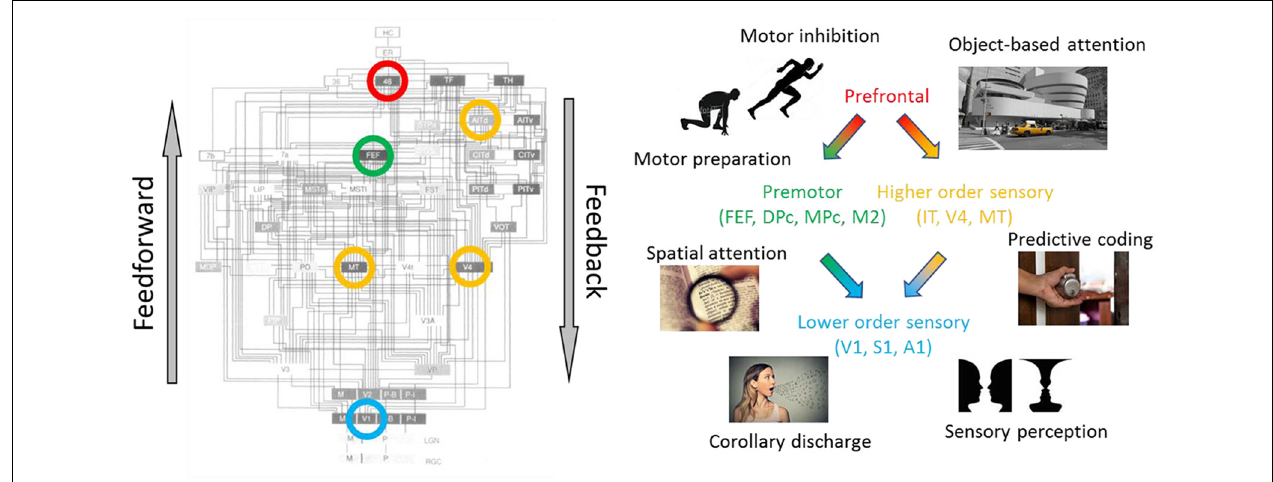
FIGURE 2 | Diverse functions of cortical feedback throughout the hierarchy. (Left) Hierarchical organization of the primate visual system adapted with permission from Felleman and Van Essen (1991). Circled regions are some of the cortical regions discussed in the manuscript. (Right) Proposed functions of cortical feedback, segregated according to source and the target region. (Red) prefrontal cortex (PFC): Brodmann area 46, dorsolateral PFC; (green) premotor cortices: FEF, frontal eye field; DPc, dorsal premotor cortex; MPc, medial premotor cortex; M2, secondary motor cortex; (yellow) higher-order sensory cortices: IT, infratemporal cortex; V4, visual area V4; MT, middle temporal visual area; (blue) lower-order sensory cortices: V1, primary visual cortex; S1, primary somatosensory cortex; A1, primary auditory cortex.